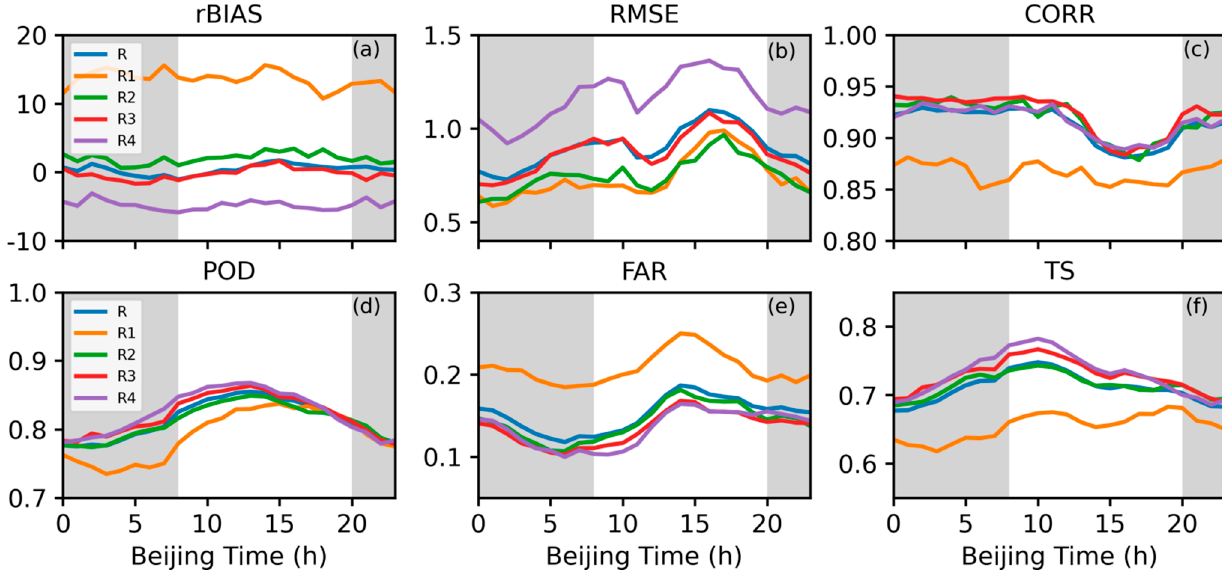
Figure 13. Comparative analysis of the daily variation of different assessment metrics of the CMPAS-NRT product in the Meiyu monitoring area (including each sub-region and the whole area) during the Meiyu period in 2020. The gray shaded area is at night (20:00–08:00 BJT). Panels ( a – f ) respectively represent the rBIAS, RMSE, CORR, POD, FAR, and